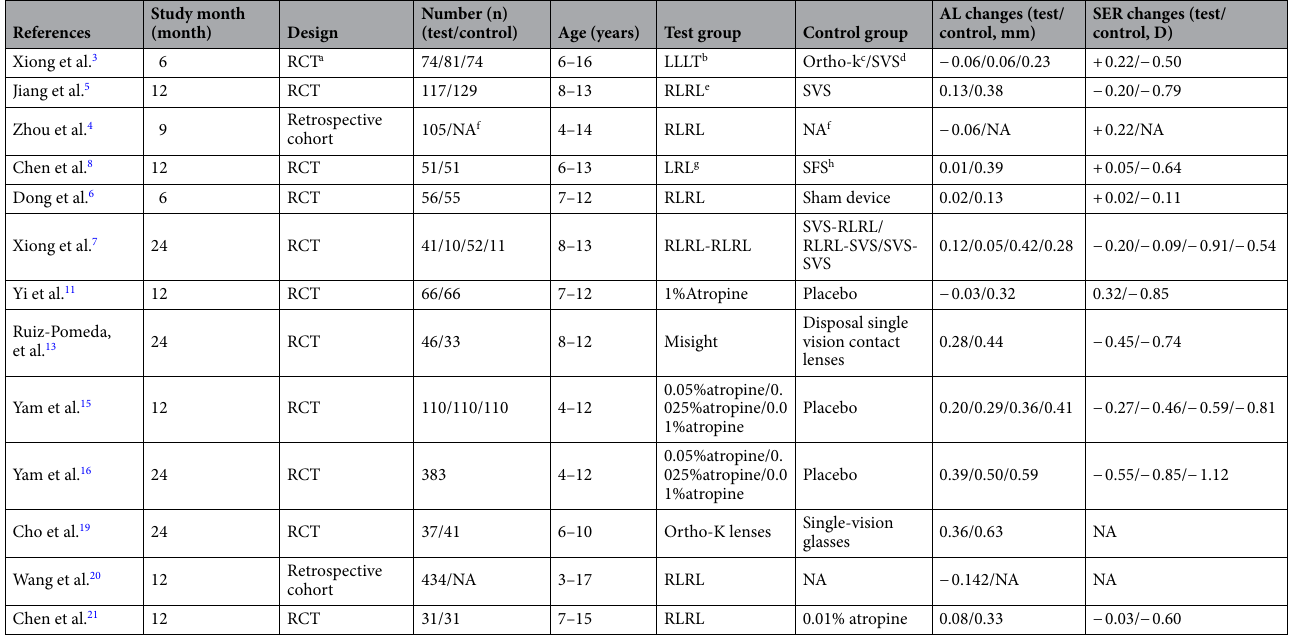
Table 5. Changes in myopic axial length in studies of PBM therapy. a RCT randomized control trial, b LLLT low level light therapy, c Ortho-K orthokeratology, d SVS single vision spectacles, e RLRL repeated low-level red light, f NA not applicable, g LRL low-intensity red-light, h SFS single focus